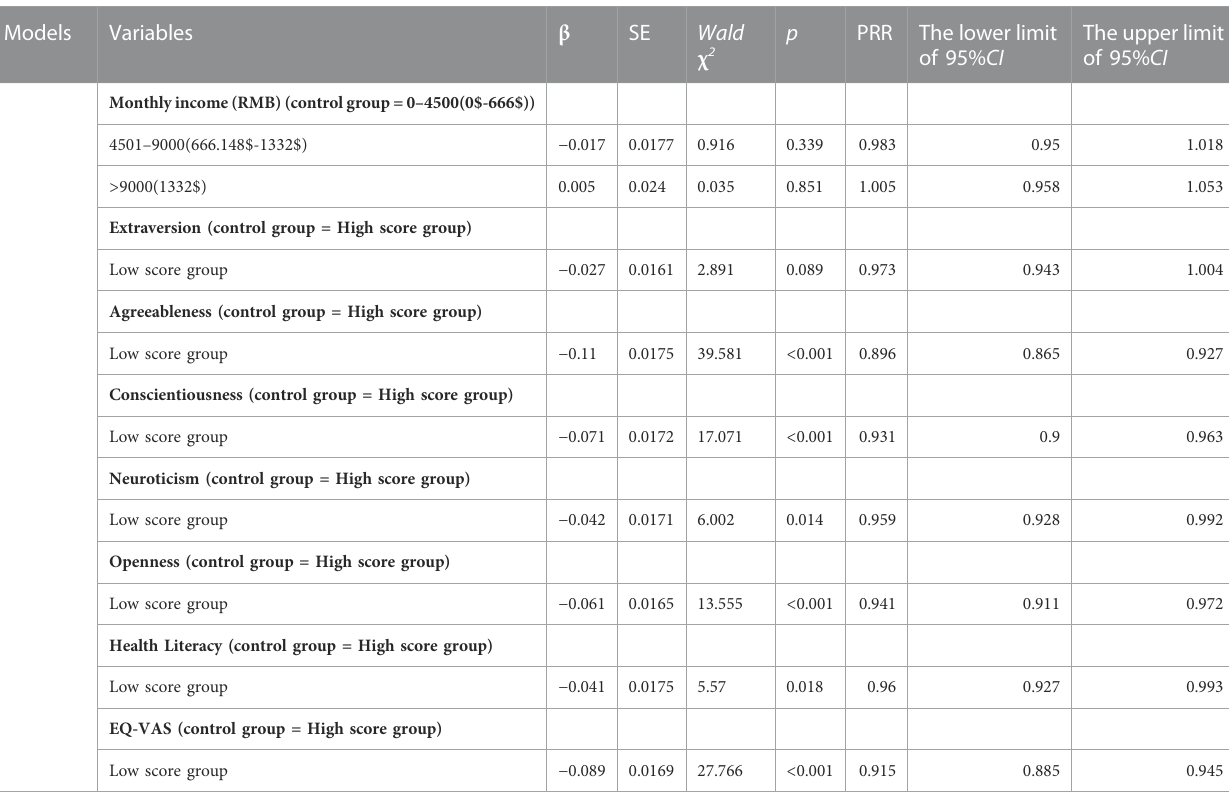
TABLE 3 ( Continued ) Multilevel log-binomial regression results with drug safety as the dependent variable